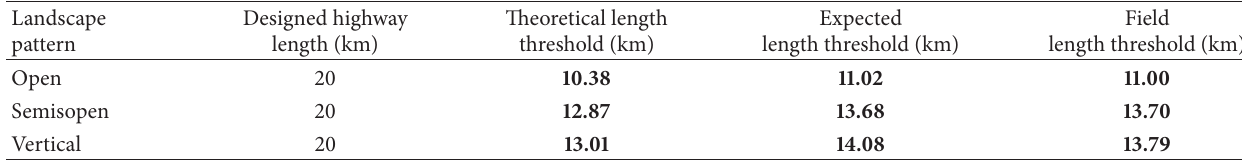
Table 6: Highway’s concluded length